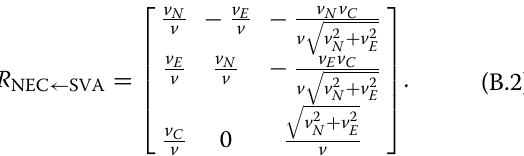
Figure 1 of Knudsen et al. (2017) illustrates the rela- tionship between the TII sensor coordinate systems ( x , y , z ) TII,H and ( x , y , z ) TII,V and the spacecraft